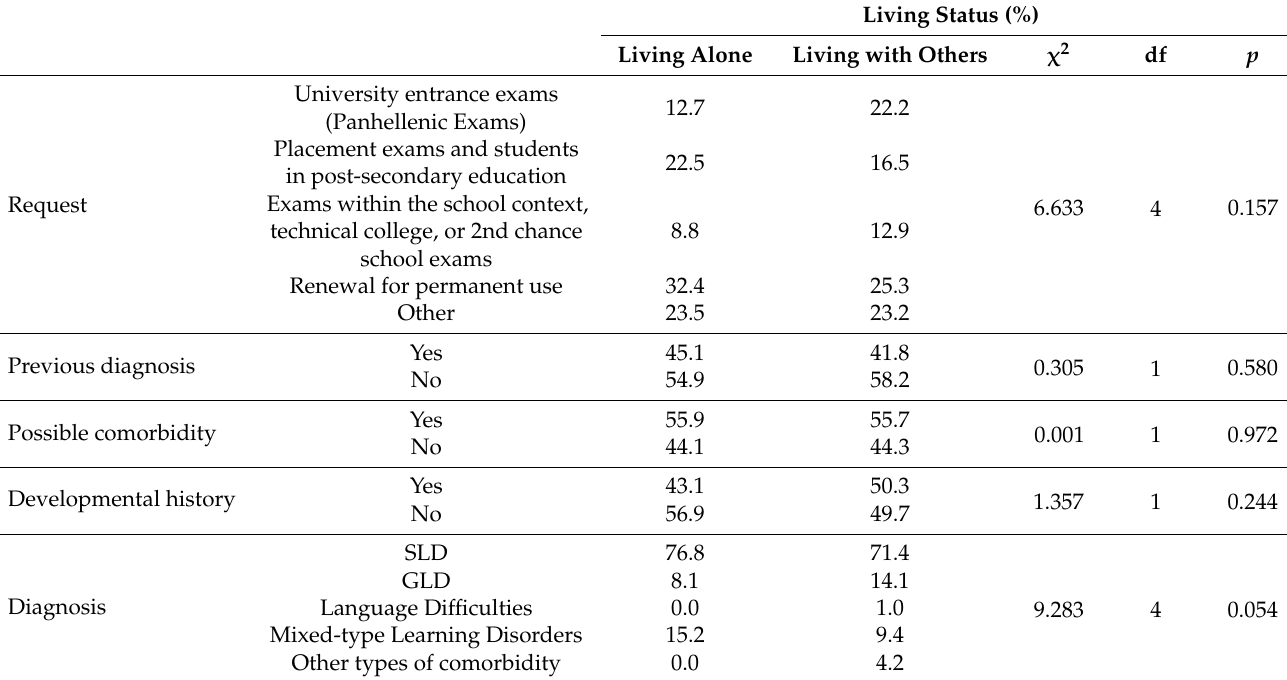
Table A2. Relationship of the Living Status of the assessed adults with the other variables.